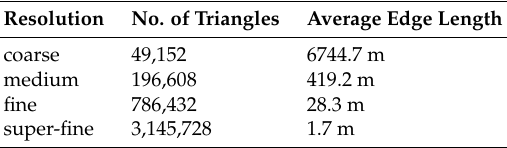
Table 1. Available resolutions of surface grid of 4 Vesta [15].